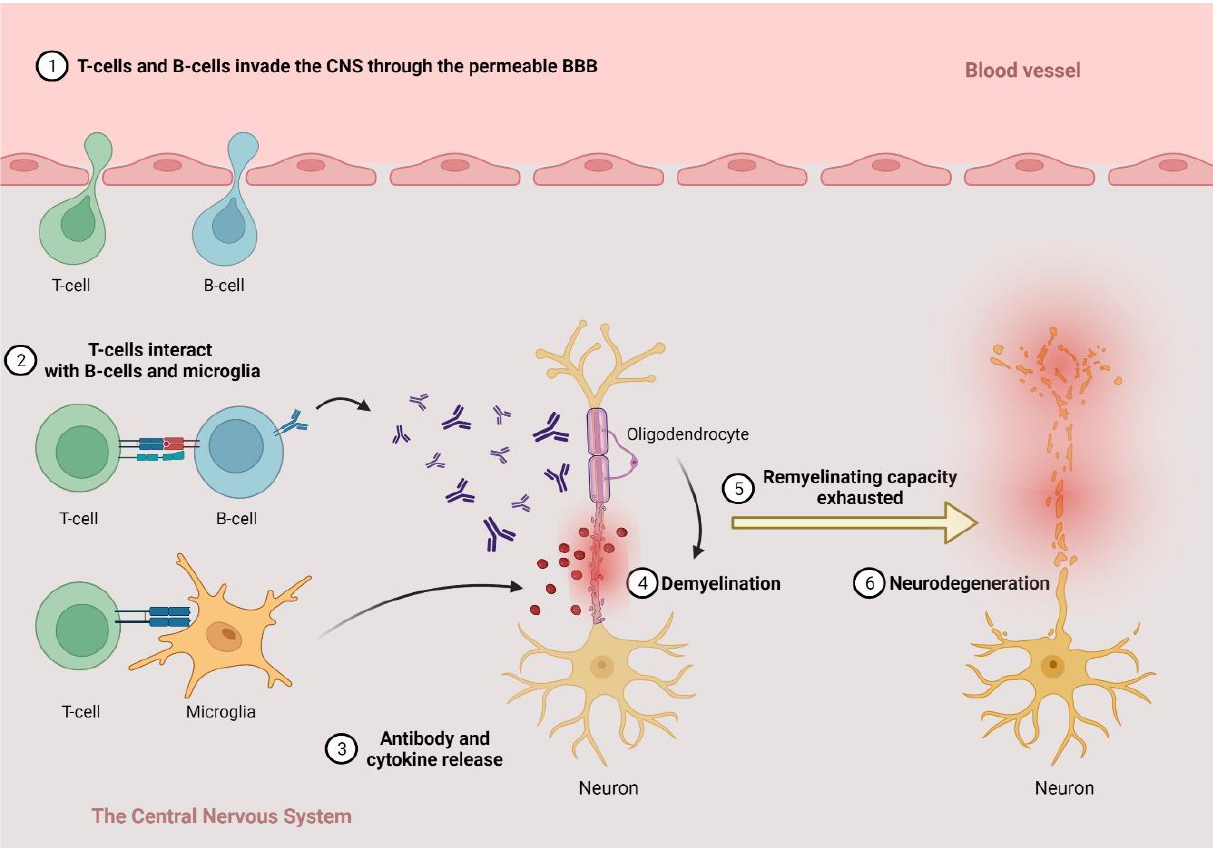
Figure 1. The schematic interpretation of the pathological processes behind multiple sclerosis. Created with BioRender.com – accessed on 25 April 2022.